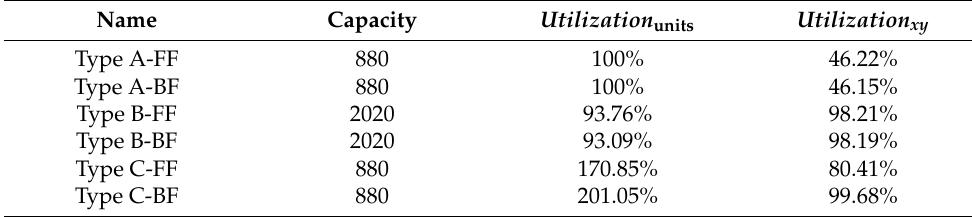
Table 4. The capacity and utilization of DC using MRCGA.